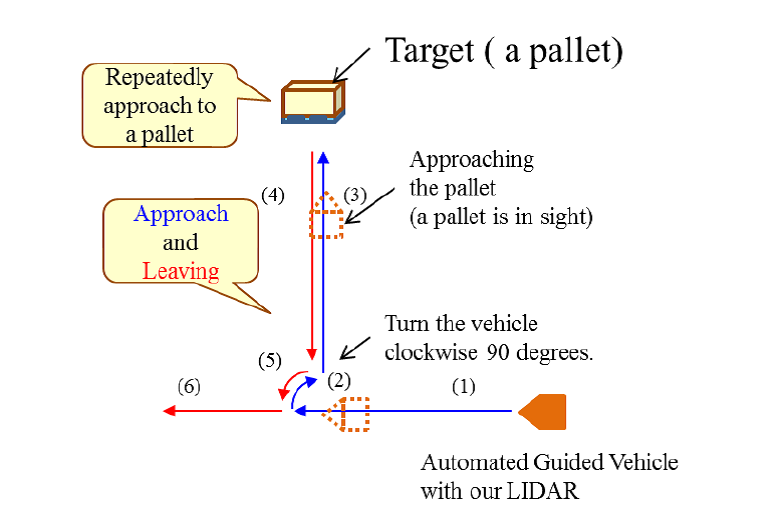
Figure 9. Example of assumed scenario 2 for AGV. The AGV equipped with the SPAD LiDAR moves in a straight line. Then, the AGV rotates clockwise by 90 degrees. Finally, the AGV automatically approaches a pallet and transports the pallet to another